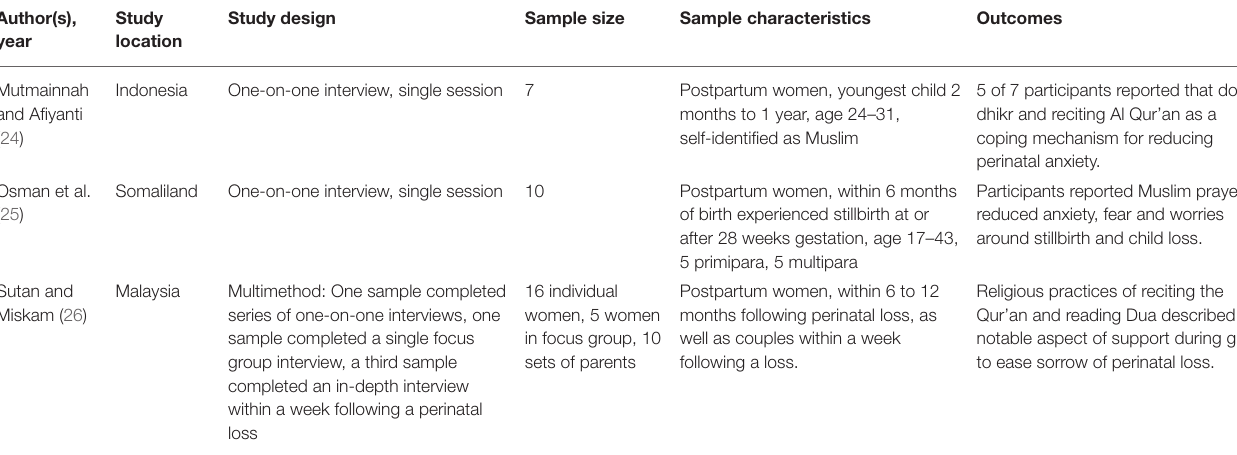
TABLE 2 | Characteristics of qualitative